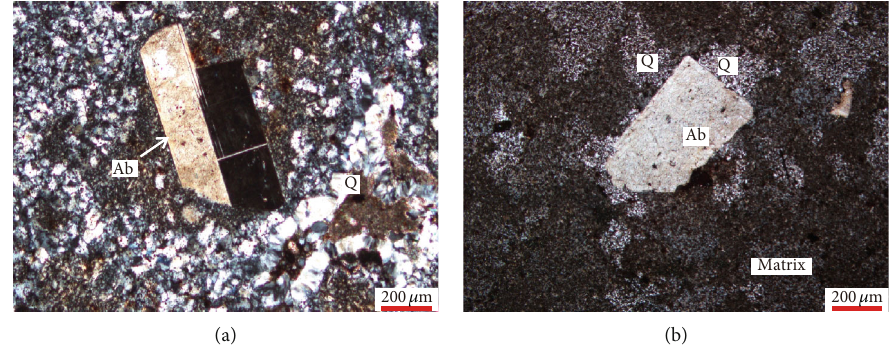
Figure 3: Microphotographs of albite porphyry from 109, showing albite occurrences as (a) a crystal in the groundmass and (b) as an erosion product of late-stage minerals or the matrix. Ab: albite; Q: quartz.